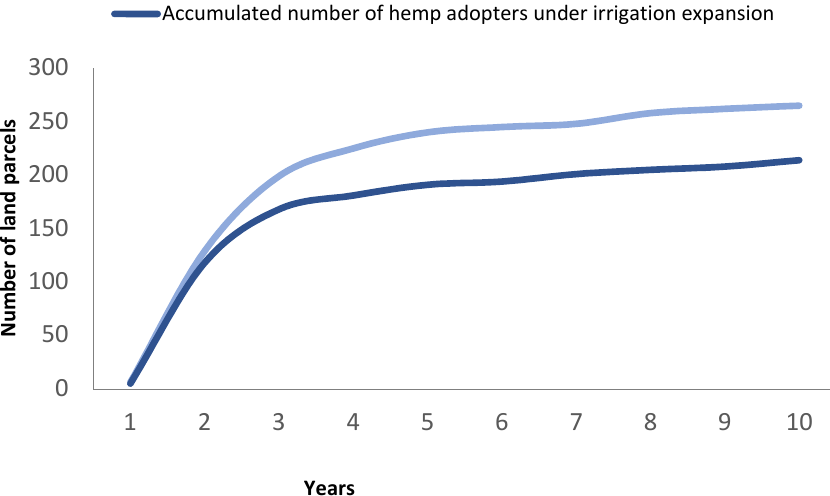
Figure 6. Hemp cumulative adoption with and without irrigation.